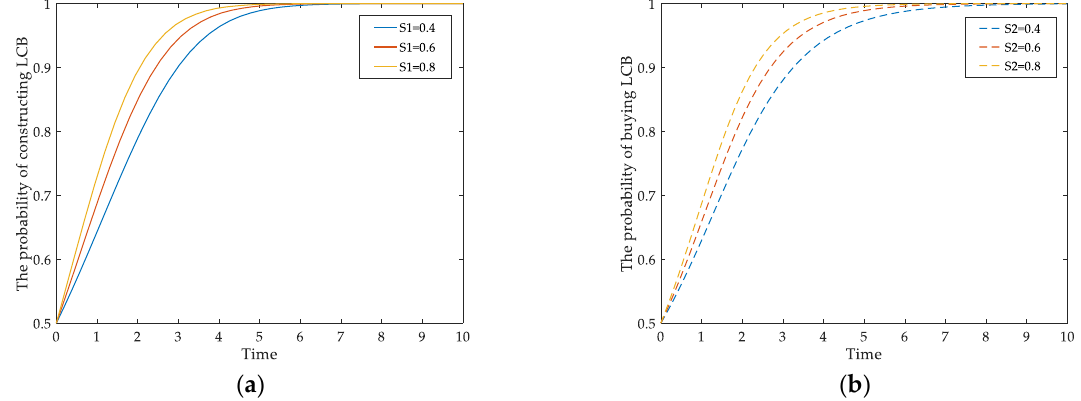
Figure 4. The impact of S 1 and S 2 on: ( a ) developer’ behavioral evolution; ( b ) homebuyers’ behavioral evolution